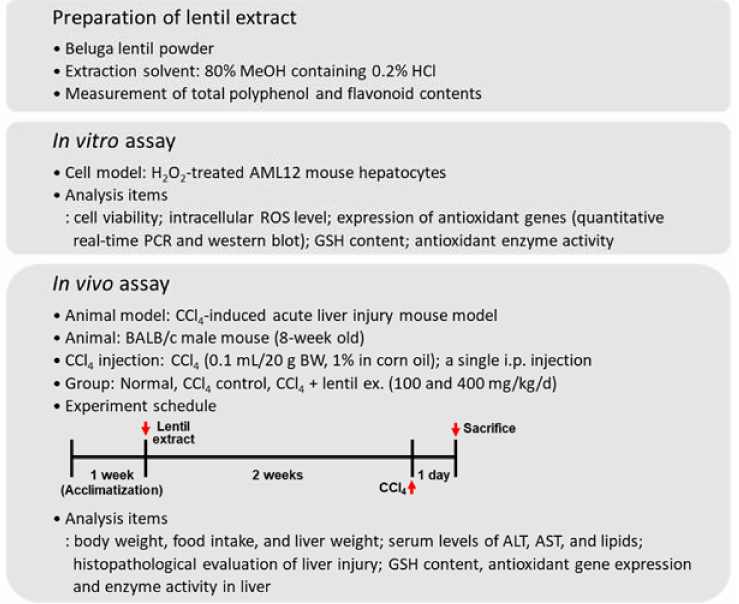
Figure 1. A summary of the research methodology of the study. ALT: alanine transaminase; AST: aspartate